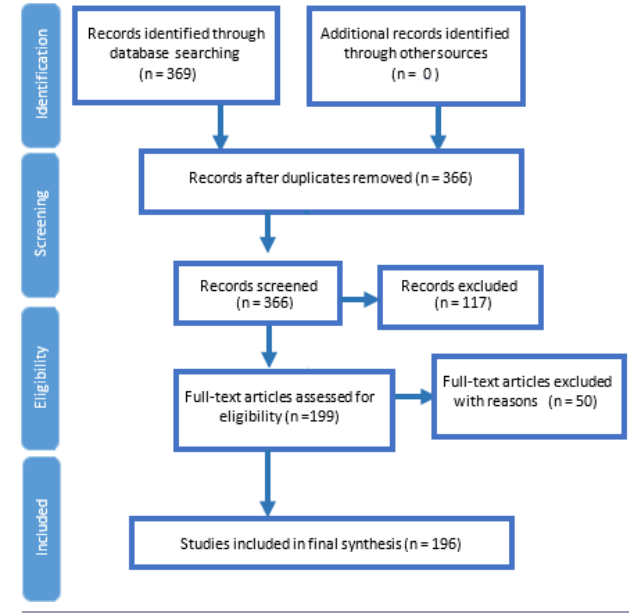
Fig. 1 . PRISMA (Preferred Reporting Items for